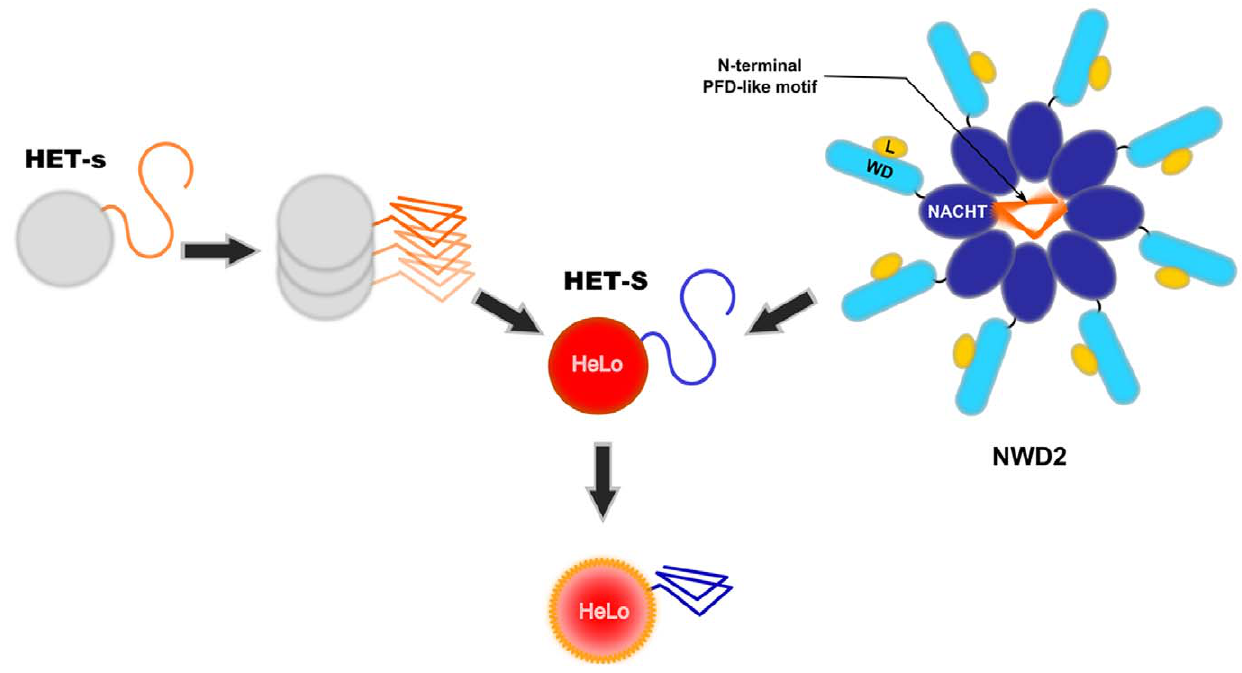
Figure 1. Two proposed mode of activation of the HeLo toxicity domain of HET-S. The current model envisioned for activation of the HeLo toxicity domain of HET-S is depicted. Upon prion formation, the C-terminal HET-s prion forming domain (PFD) adopts the b -solenoid amyloid fold. The b -solenoid fold of HET-s then serves as a template to transconform the corresponding region in the HET-S protein. Refolding of the HET-S PFD region leads to a refolding of the globular HeLo domain, and this refolding renders the protein toxic. The NWD2 protein displays three domains: an N- terminal motif homologous to the HET-s PFD, a central NACHT oligomerisation domain, and a C-terminal WD-repeat domain (WD). It is proposed that upon binding of a ligand (L), NWD2 undergoes oligomerisation and that this oligomerisation allows the N-terminal region of the NWD2 protein to adopt a HET-s-like b -solenoid fold. This N-terminal extension would then lead to templating and activation of the HET-S HeLo domain (in a way analogous to